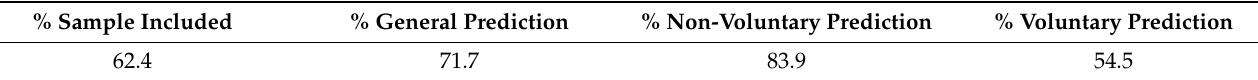
Table 6. Classification of sub-groups included in the